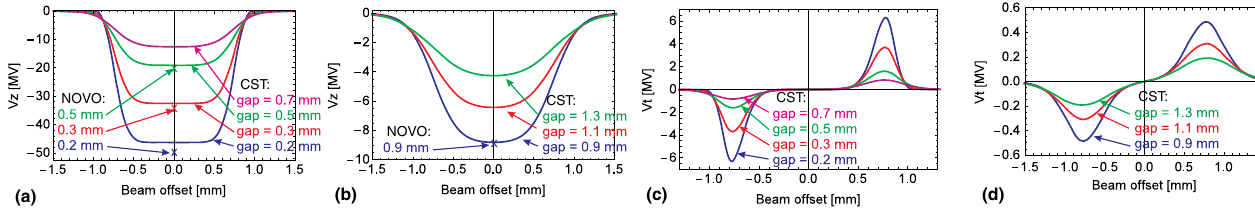
FIG. 3. Deceleration voltage [(a) and (b)] and transverse voltage [(c) and (d)] as a function of the horizontal beam-structure displacement, for different gaps. The fields are generated by a 3.2 nC bunch with σ are calculated with CST , the “ X ” points with the code NOVO .